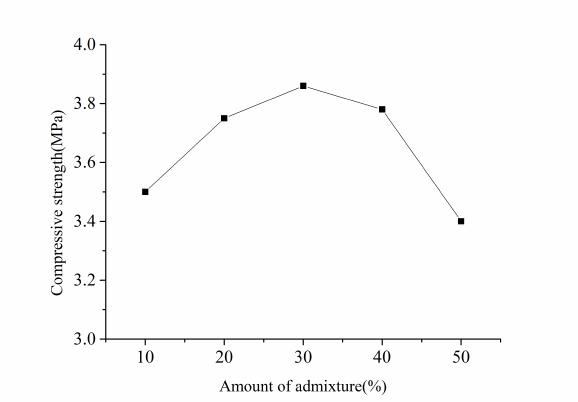
Figure 5: Compressive strength versus ferrosilicon alloy powder content